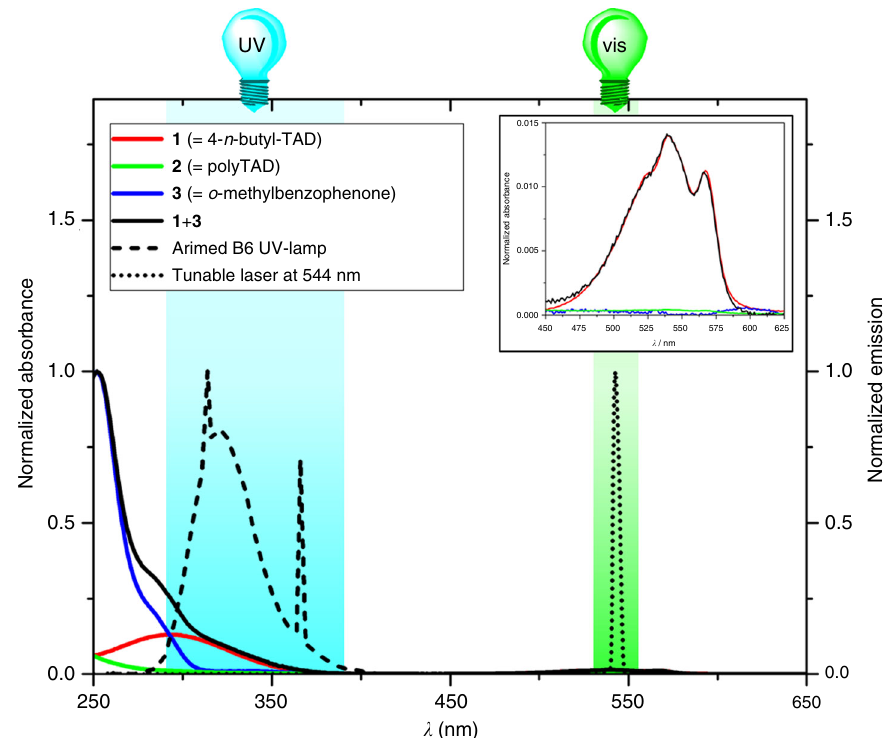
Fig. 3 λ -orthogonality principle. Illustration of the required wavelength-dependent excitation of 4- n -butyl-TAD 1 (red), photopolymer 2 (green), and o -methylbenzophenone 3 (blue) with visible laser light (dotted) and readily available UV-emitting fl uorescent lamps (dashed), respectively, to enable a λ -orthogonal system of 1 + 3 (black). All absorption spectra were recorded in chloroform at 25